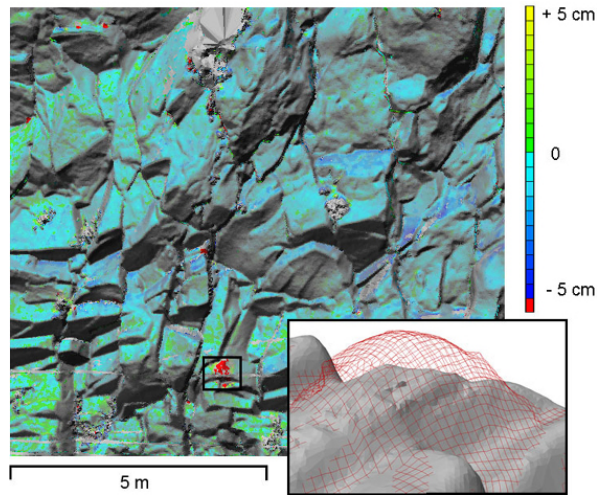
Fig. 10. Multi-temporal comparison of the TLS point clouds from May 2008 and December 2008. Changes beyond a basic scatter value are due to different scan positions and instrumental errors. Small scale rockfalls are visualized in red. The enlarged view of the marked area (box) shows a missing volume of 0.5m 3 between the scan of May 2008 (red mesh) and December